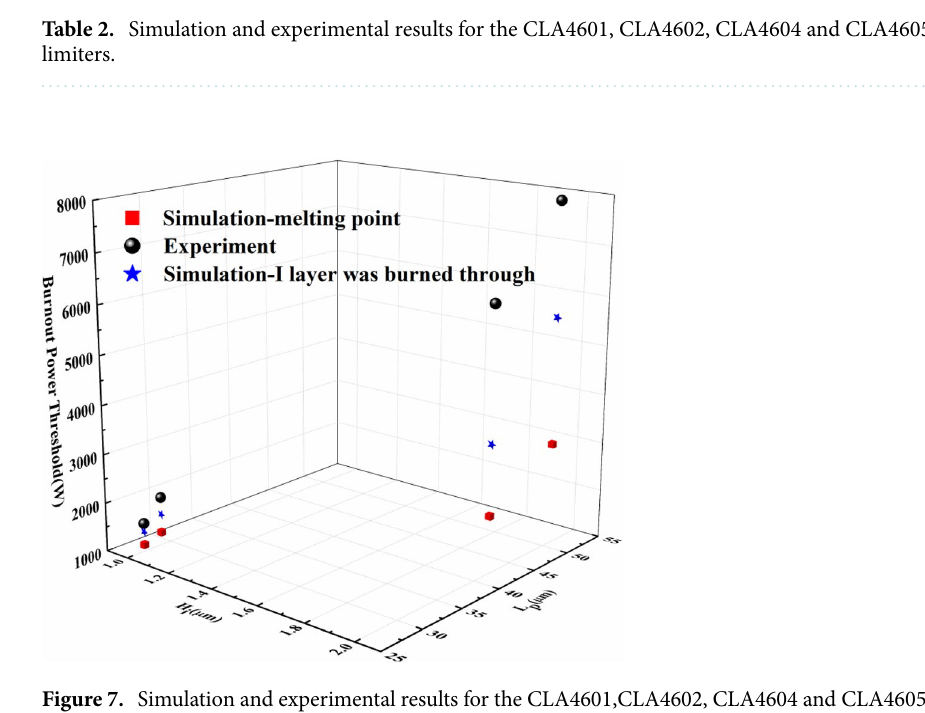
Figure 7. Simulation and experimental results for the CLA4601,CLA4602, CLA4604 and CLA4605 silicon